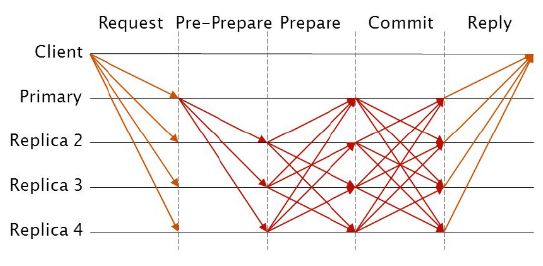
Figure 2. Procedure of PBFT consensus algorithm.